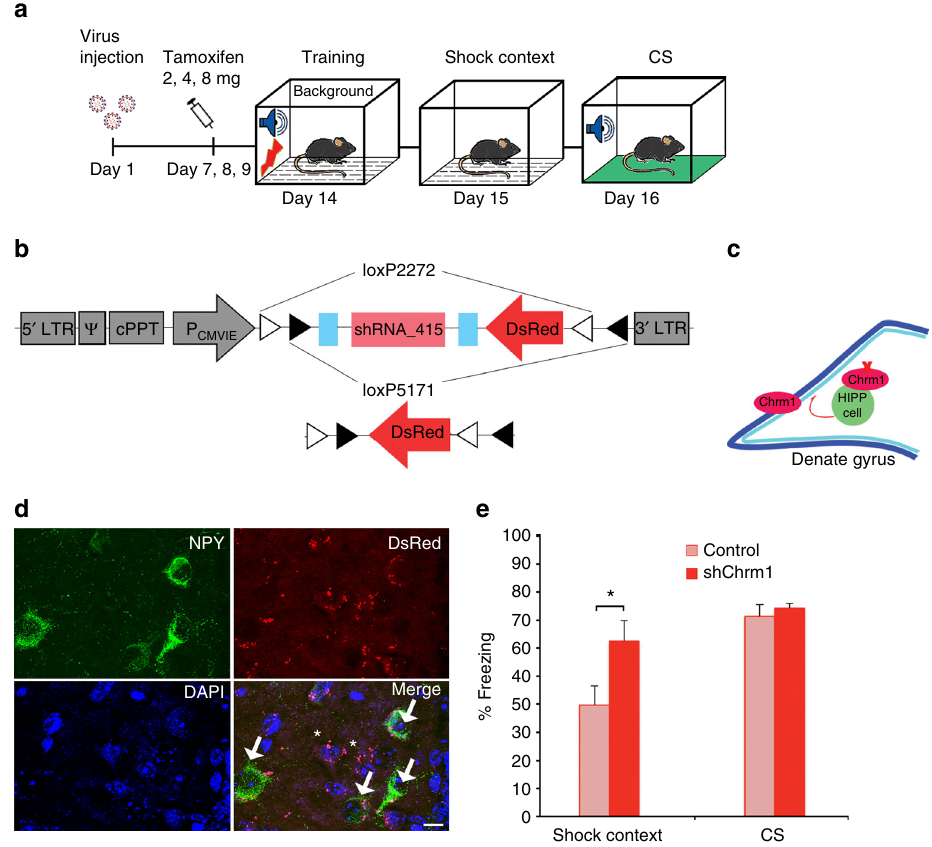
Fig. 5 Chrm1 knock down in HIPP cells increases background context memory. a A schematic of the behavioral paradigm. b Lentiviral vector constructs for the conditional knockdown of Chrm1 and control vector. c Schematic of the proposed circuit. d Representative microscopic images show lentiviral expression of the DsRed marker in NPY + cells ( arrows ) and NPY − cells of the hilus ( asterisks ). Scale bar, 10 μ m. For an overview refer to Supplementary Fig. 9f. e The knockdown of Chrm1 in SST-Cre ERT2 mice ( n = 8) signi fi cantly increases the memory to background context (controls n = 7), while the conditioned response to the CS remains unaffected. Data are means+ s.e.m. Statistical analysis was done with Student ’ s unpaired t -test. * P <